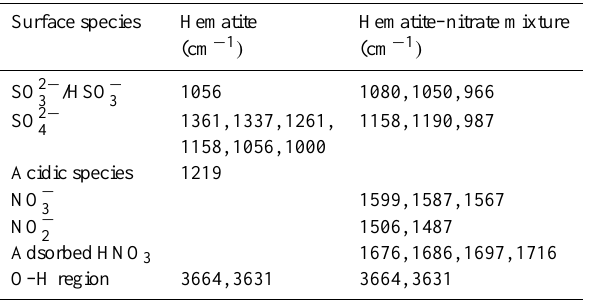
Table 1. Assignment of vibrational frequencies of surface species formed on hematite particle surfaces and on hematite–nitrate mix- tures